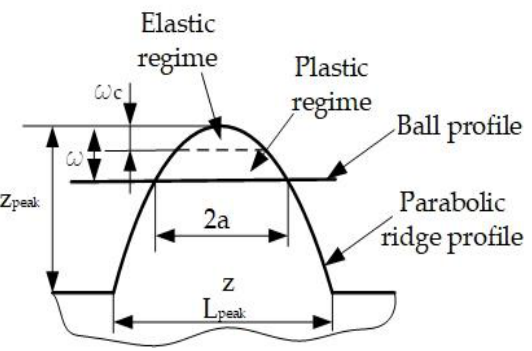
Figure 7. Two-dimensional elastic–plastic interaction of an individual Δy length parabolic ridge with a smooth surface.